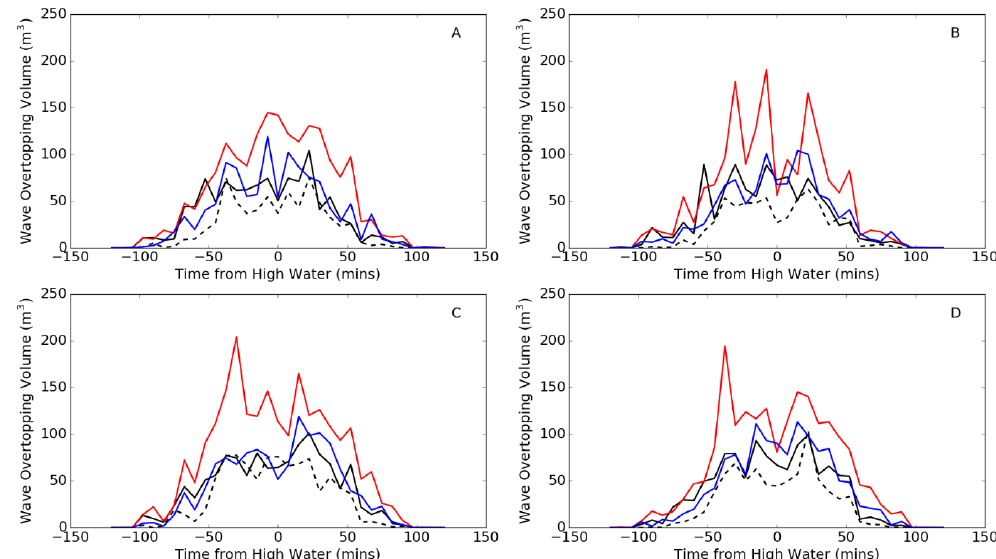
Figure 5. Time-varying wave overtopping for Scenario 1 ( A ), Scenario 2 ( B ), Scenario 3 ( C ) and Scenario 4 ( D ), under the applied morphological profiles: measured seasonal profile with morphology disabled (dashed black line), measured seasonal profiles with morphology enabled (solid black line), pre-storm with morphology disabled (red line) and post-storm with morphology disabled (blue line).